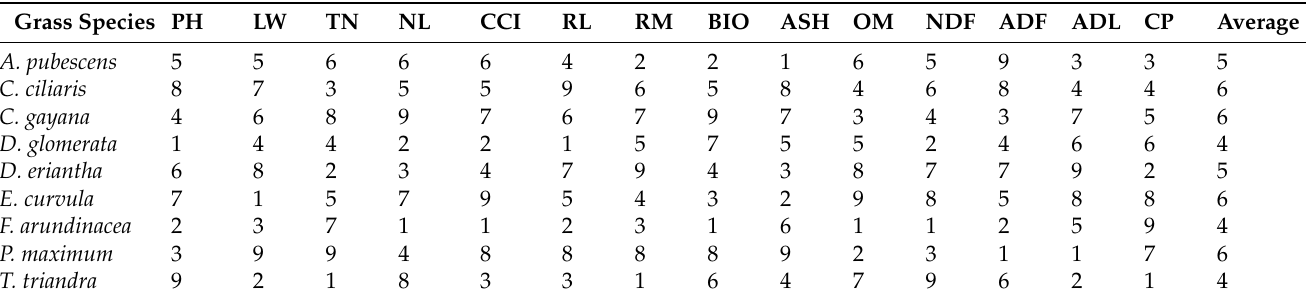
PH = plant height; LW = leaf width; TN = tiller numbers; NL = number of leaves; CCI = chlorophyll; RL = root length; RM = root mass; BIO = biomass; Ash, CP = crude protein; OM = organic matter; NDF = neutral detergent fibre; ADF = acid detergent fibre; ADL = acid detergent